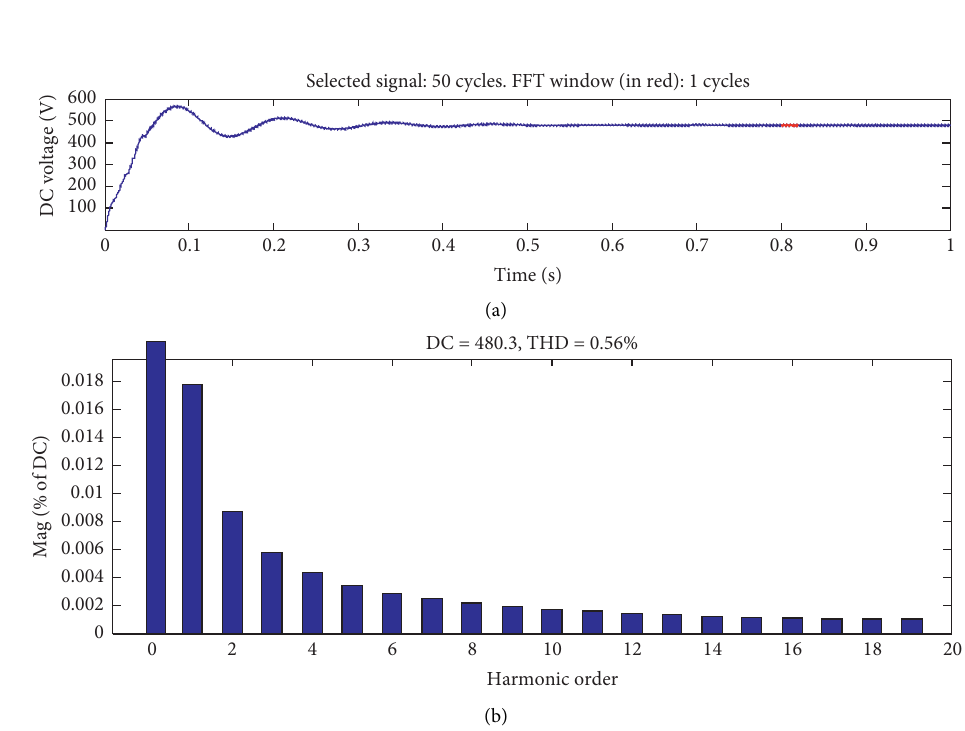
Figure 13: Spectral analysis of the output voltage.